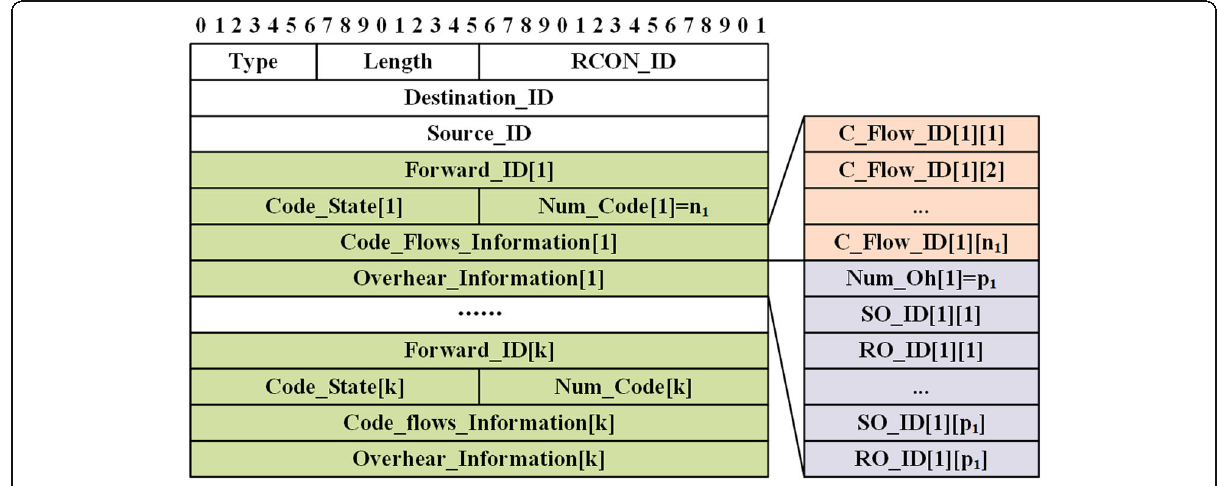
Fig. 16 Structure of RCON Message. Figure 16 shows the structure of RCON message, including the name of fields and their